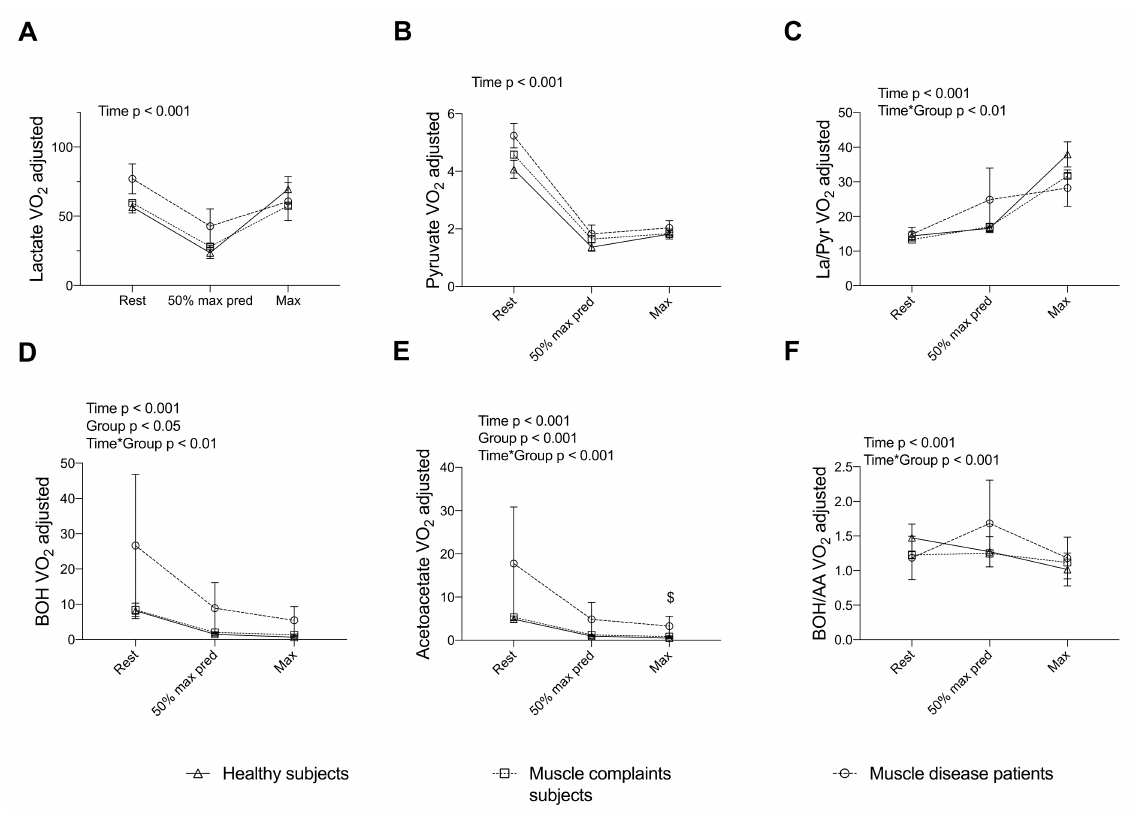
Figure 2. V’O 2 -adjusted biological parameters measured by routine automate in healthy subjects, muscle complaint subjects and muscle disease patients during CPET: ( A ) lactate; ( B ) pyruvate; ( C ) lactate/pyruvate ratio; ( D ) beta-hydroxybutyrate; ( E ) acetoacetate and ( F ) beta- hydroxybutyrate/acetoacetate ratio. Each patient was measured at three timepoints: rest, 50% of predicted maximal intensity and at maximal intensity. Data are presented as mean ± SEM at each time point. Significant p -value for post-hoc test $: healthy vs. muscle complaint subjects. AA: Acetoacetate; BOH: beta-hydroxybutyrate; CPET: Cardiopulmonary Exercise Test; La: lactate; Pyr: pyruvate; SEM: Standard Error of the